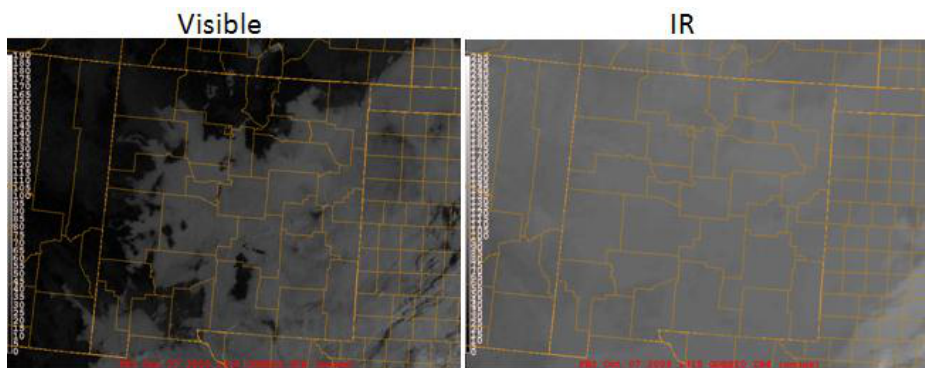
Fig. 6: The difference between visible and infrared satellite image in detecting fog taken by goes 4 km resolution.